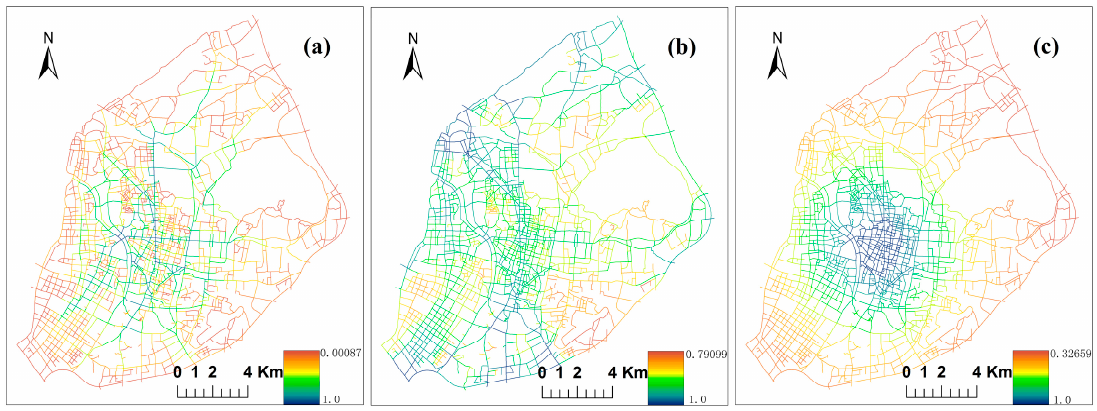
Figure 6. Network cross K-function analysis between hospitals and pharmacy stores in main urban districts.